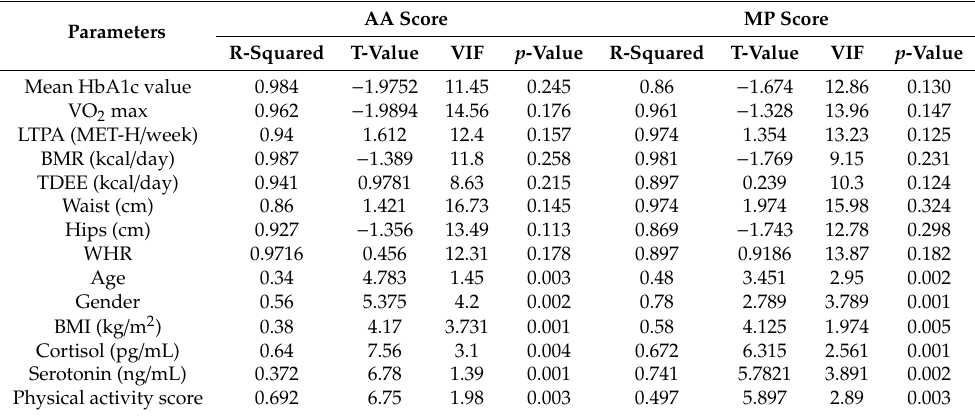
Table 4. Multicollinearity test diagnostics and selection of stepwise linear regressed cofounders. AA Score MP Score Parameters T-Value Mean HbA1c value